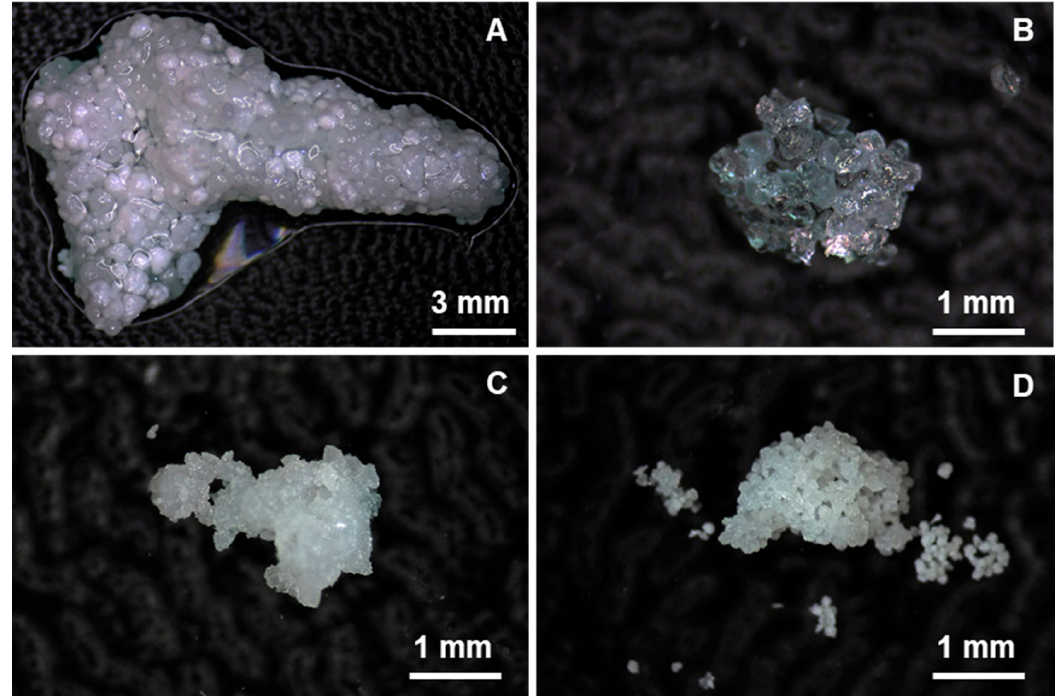
Figure 8. Microscope images of wet agglomerates formed during the removal of 100 mg microplastics from 1 L demin, water using 100 μ L organosilane. ( A ) = PE ‐ X and PE/PP (1:1), ( B ) = n ‐ Butyltrichlorosilane and PA, ( C ) = Isooctyltrichlorosilane and PES, ( D ) = (3 ‐ Chloropropyl)trichlorosilane and PVC.